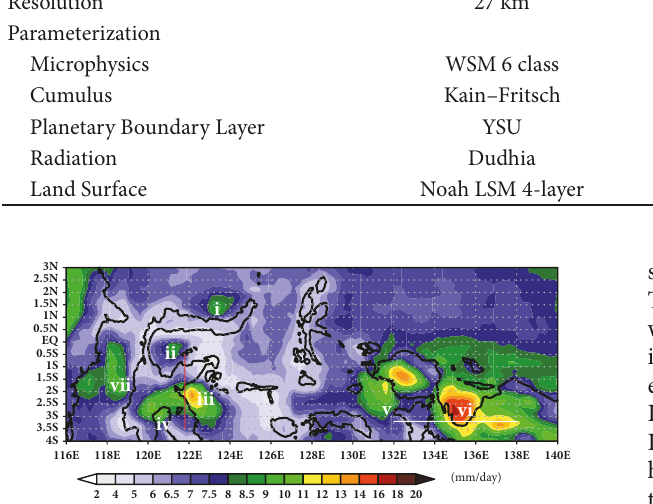
Figure 2: Total mean of offshore rainfall over Indonesian Maritime Continent based on composite TRMM during 1998 to 2015. The heavy offshore rainfall occurs over (i) Manado Bay, (ii) Tomini Bay, (iii) Tolo Bay, (iv) Bone Bay, (v), Berau Bay, (vi) Cenderawasih Bay, and (vii) Strait of Makassar. Red line cross section for Tolo Bay and white line cross section for Cenderawasih